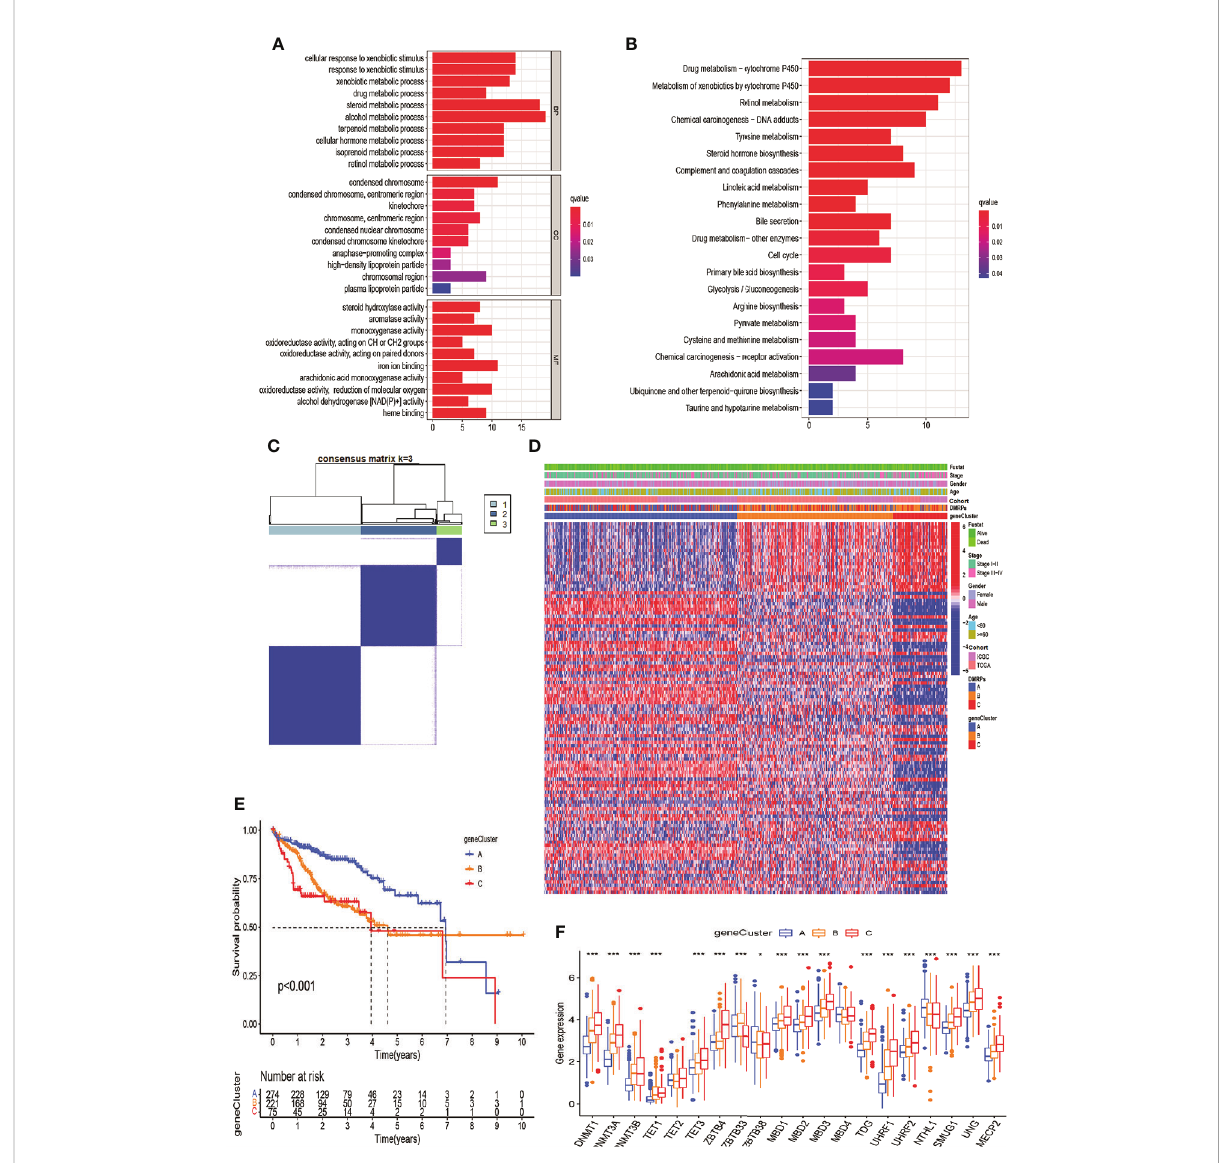
FIGURE 5 DNA modi fi cation pattern-related DEGs and gene clusters in HCC. (A, B) GO and KEGG enrichment analysis for DEGs of DMRPs. (C) Consensus cluster matrix of 570 patients for k = 3. (D) The relationship of clinical characteristics and unsupervised clustering of DEGs. (E) Kaplan-Meier curves of three gene clusters. (F) The expression levels of 20 DNA methylation regulators among three gene clusters. * P < 0.05, ** P < 0.01, *** P < 0.001, **** P <